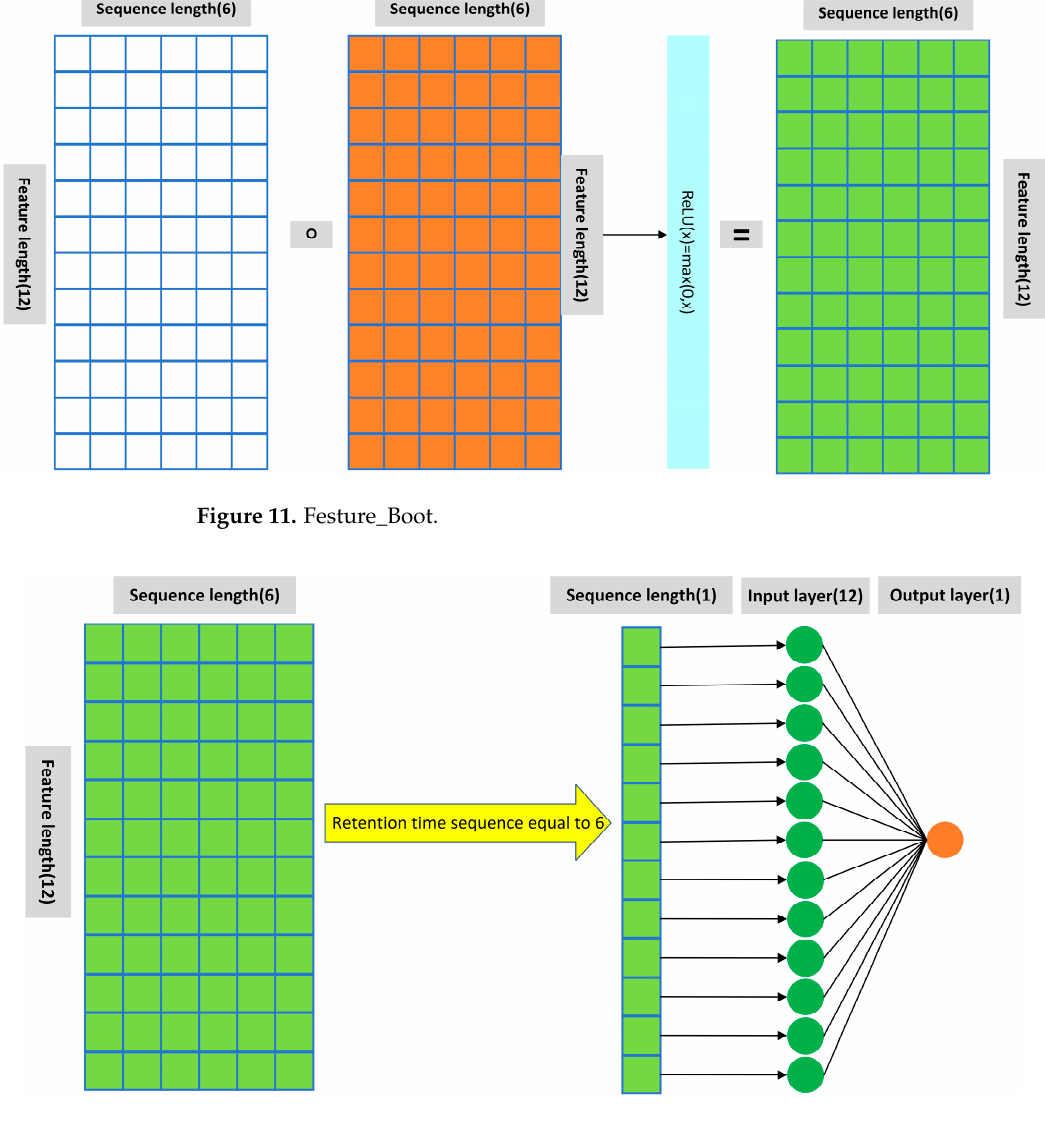
Figure 13. Experimental steps.